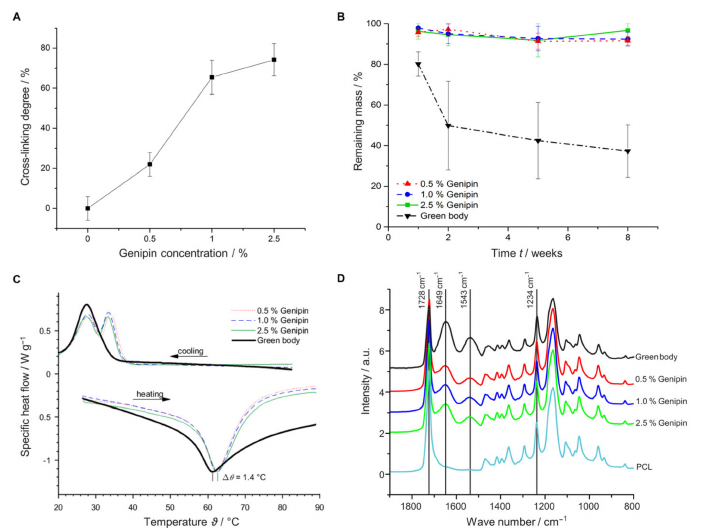
Figure 2. Characterization of scaffolds with different cross-linker concentrations (0.5%, 1.0%, and 2.5% genipin) and the non-cross-linked control (green body). ( A ) Cross-linking degree ( α cl ). ( B ) Degrada- tion study in buffer solution for 8 weeks. ( C ) DSC measurements. ( D ) ATR-FTIR